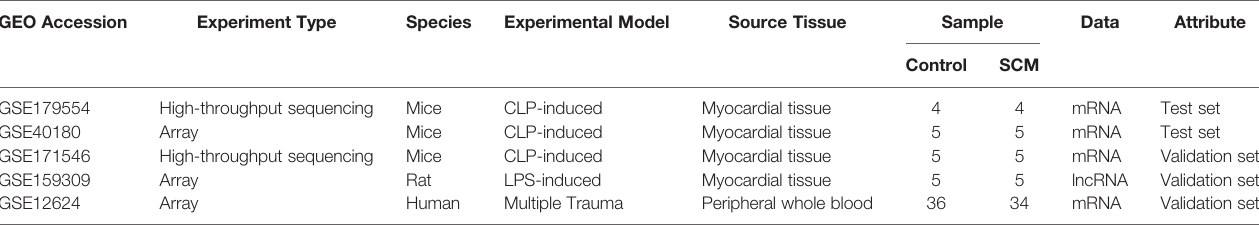
TABLE 1 | Information of selected microaray